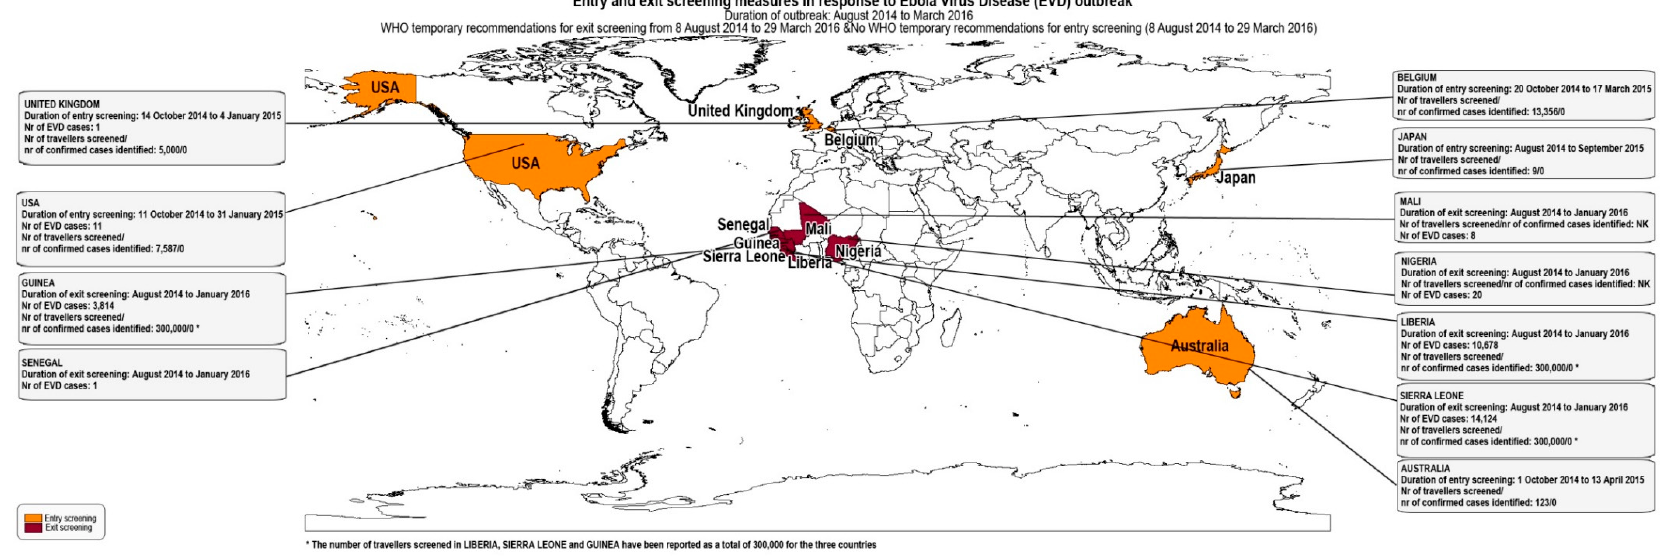
Figure 4. Published entry and exit screening measures in response to Ebola virus disease outbreak [16,27,31,34,38,41].